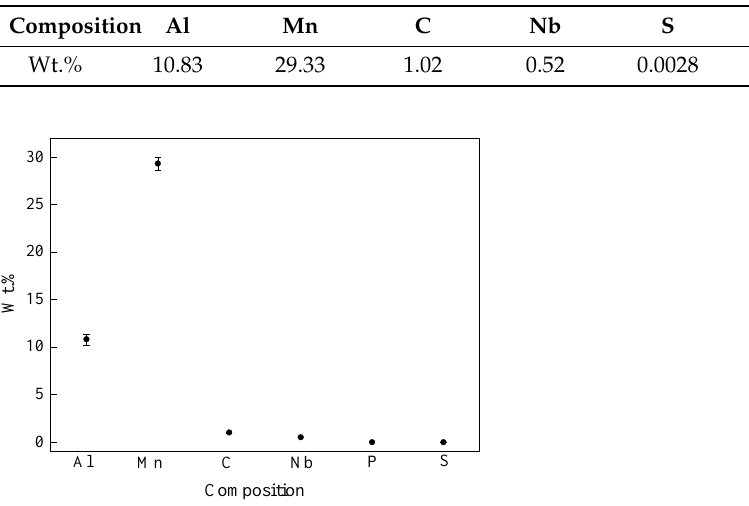
Figure 2. Chemical compositions of the designed steels with error bars. Metals 2021 , 11 , x FOR PEER REVIEW